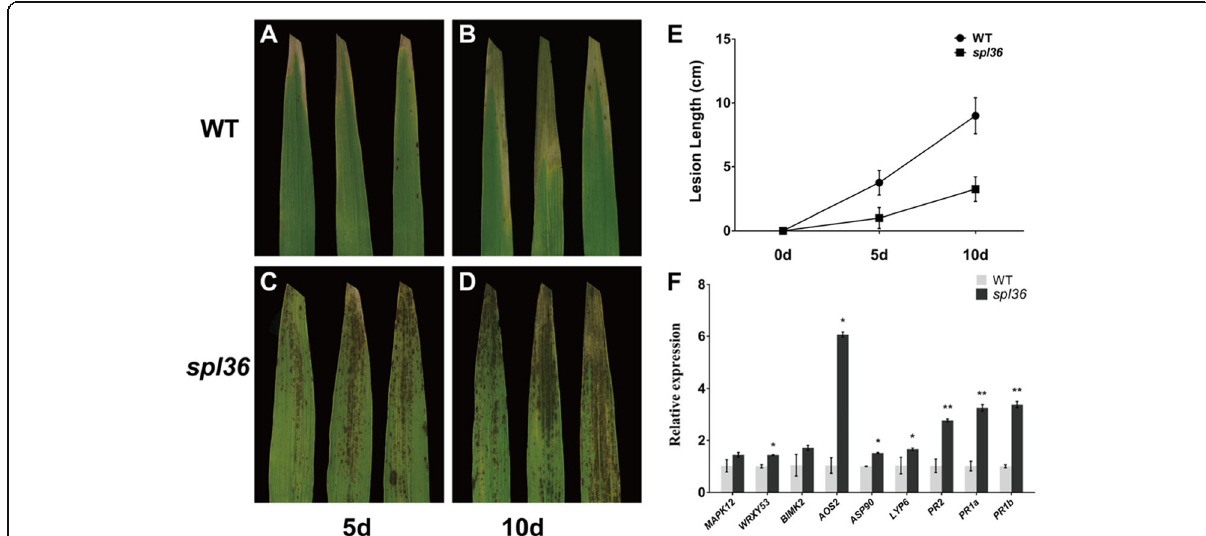
Fig. 4 SPL36 regulates defense responses in rice. a-d Phenotypes of wild-type and spl36 leaves at 5 days and 10 days after inoculation with the bacterial blight pathogen HM73. e Statistical analysis of the length of bacterial leaf blight lesions. f Relative expression of defense-related genes in uninoculated plants